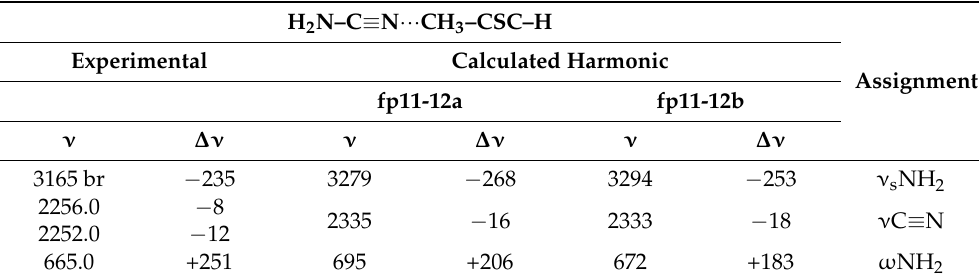
Table 4. Wavenumbers and wavenumbers shifts ( ∆ ν = ( ν comp − ν mon )) (in cm − 1 ) calculated and